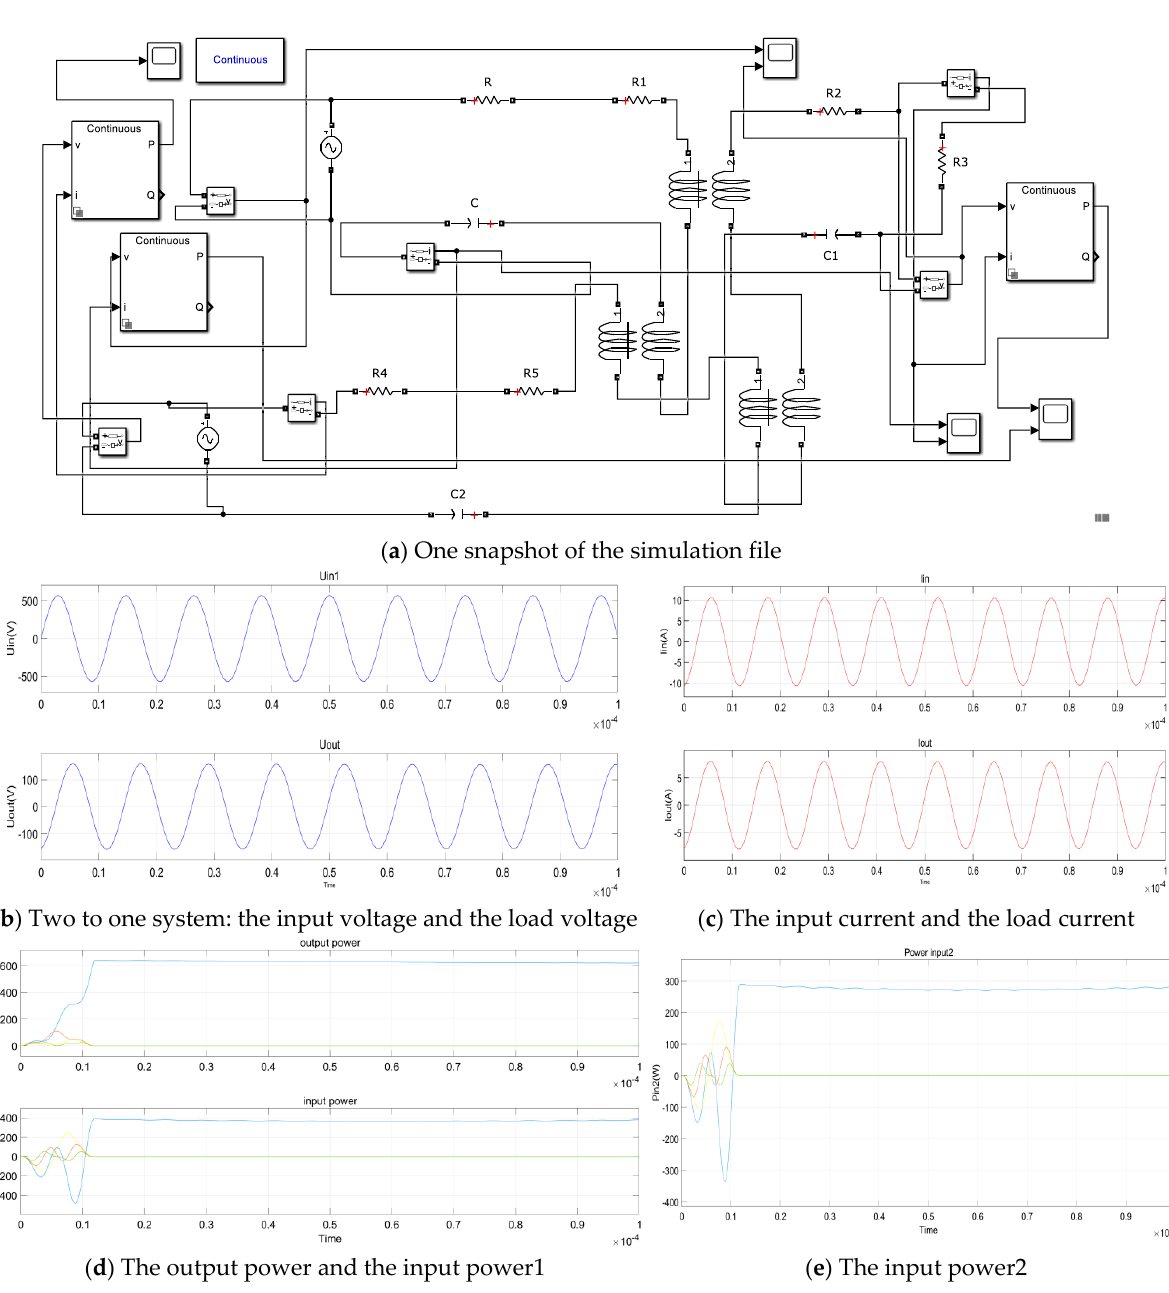
Figure 6. Waveforms of the transmitter currents and the load voltage. (a) Snapshot of Matlab simulation (b) Voltage (c) Current (d) Output power and input power 1 (e) input power 2.